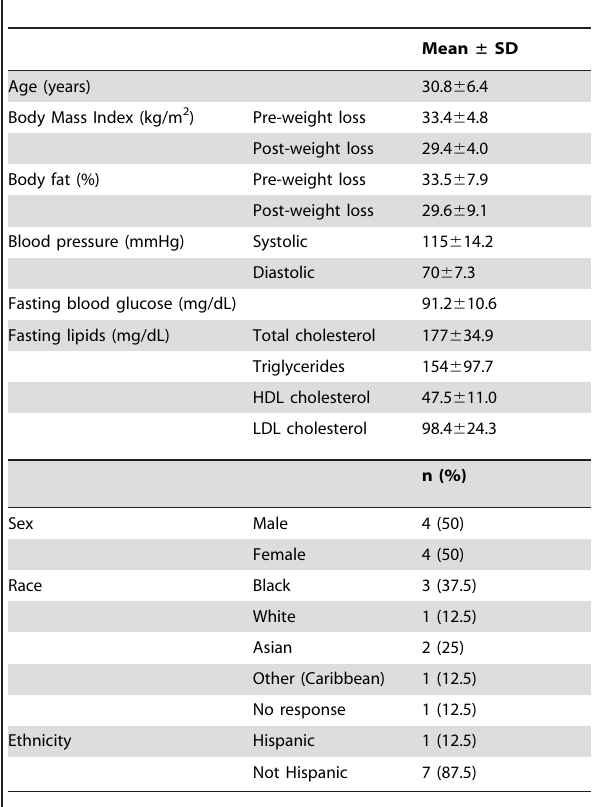
Table 3. Baseline characteristics of the study